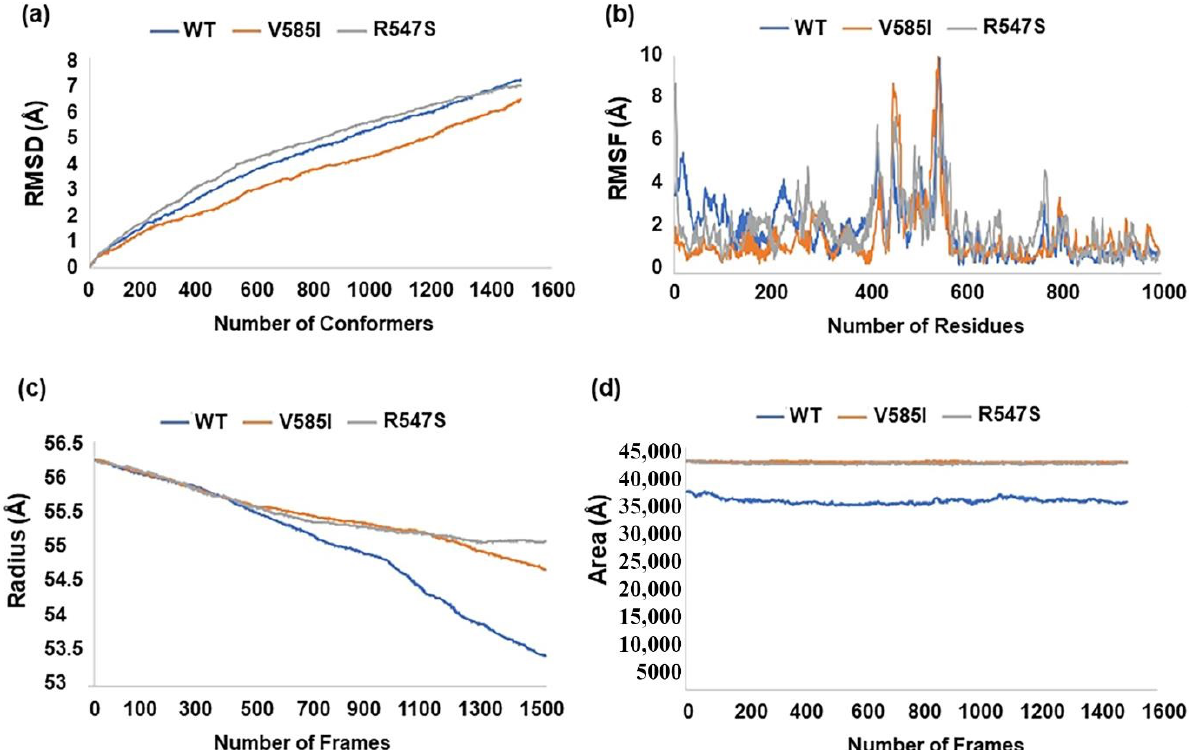
Figure 5. Dynamic impact of substitutions in the CARD14 protein structure. ( a ) Plot of root mean square deviation (RMSD). ( b ) Plot of root mean square fluctuation (RMSF). ( c ) Plot of radius of gyration (Rg). ( d ) Plot of solvent surface accessible area (SASA).